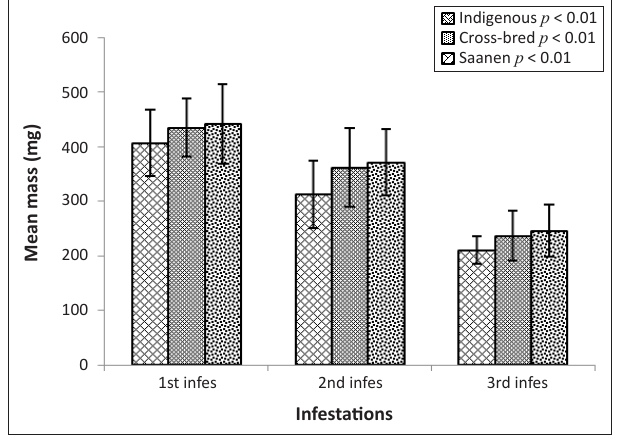
FIGURE 2: Mean engorged mass of female ticks (mg) recovered during three consecutive infestations of Rhipicephalus appendiculatus from South African Indigenous goats (Nguni), cross-bred and Saanen